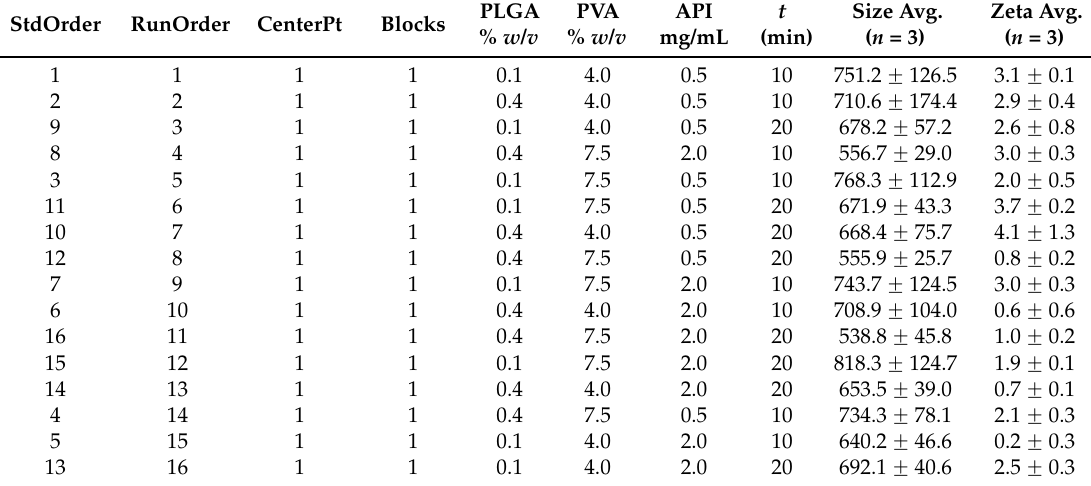
Table 1. Minitab batch composition. The four independent variables studied are; poly DL -lactic- co -glycolic acid (PLGA), polyvinyl alcohol (PVA), amount of prednisolone (API) concentrations and homogenization time ( t ); a partial factorial design with one center point was selected. StdOrder RunOrder CenterPt Blocks